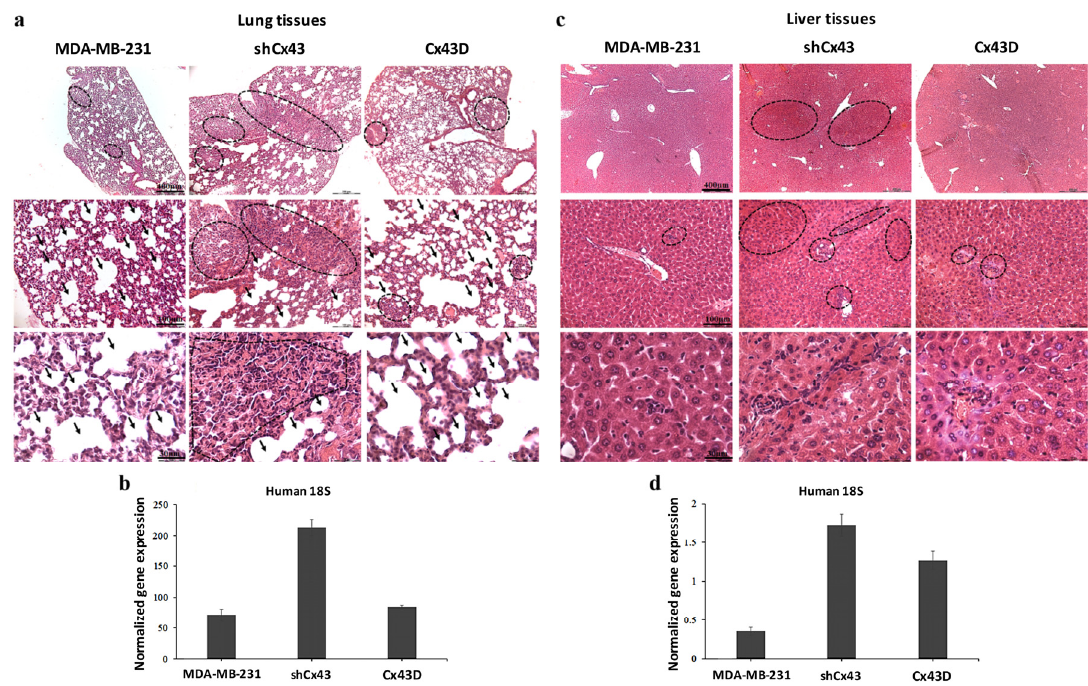
Figure 7. Down-regulation of Cx43 enhances breast cancer metastasis to the lung and liver. ( a , c ) H&E staining showing metastatic foci in lung and liver tissues, respectively, at week 9 post-injection of parental MDA-MB-231, shCx43 or Cx43D cells. ( b , d ) qPCR analysis of human 18S ribosomal RNA levels, in lung and liver tissues of mice bearing MDA-MB-231, shCx43 or Cx43D cells.